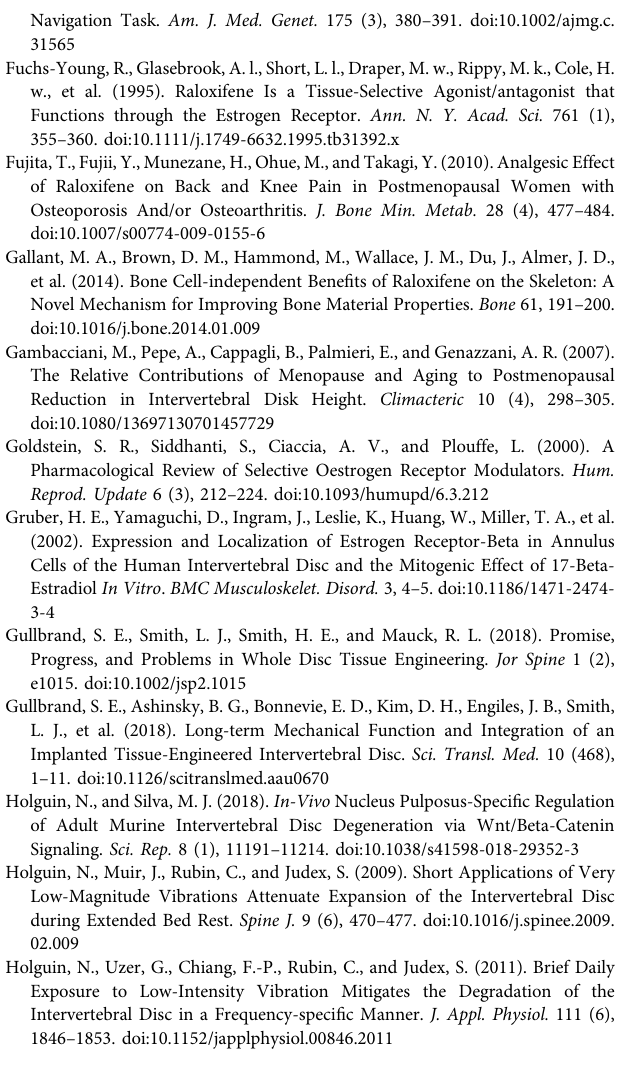
Supplementary Figure S10 | High magni fi cation of the NP of (Left: (A – C) ) SP- stained IVD and (Right: (A – C) ) the respective negative controls. The presence of protein stain is indicated by an arrow, whereas the absence of protein staining is indicated by an arrowhead. Scale: 50 μ m. Supplementary Figure S11 | Substance P protein cell count in the AF was increased by OVX and suppressed by raloxifene. Cell count of substance protein expressingcellsinthe(A)AFand(B)NPof young-adult(4 months),OVX(6 months), and old (24 months) mice. Data are represented as box plots with mean marked as cross (x), 25/75% deviation lines, and maximum/minimum whiskers. *: Control (CON, n = 5/sex/group) vs. raloxifene (RAL); R: CON vs RAL; S: male vs. female; RxS: interaction; vehicle (VEH, n = 8/group) vs RAL, SHAM ( n = 4 – 5/group) vs ovariectomized(OVX),p < 0.05.AF,annulus fi brosus;NP:nucleuspulposus;andND, not determined. Supplementary Figure S12 | ER- α staining in 4-month osteocytes. The presence of protein stain is indicated by an arrow, whereas the absence of protein staining is indicated by an arrowhead. Scale bar: 50 μ m. Supplementary Figure S13 | Substance P staining in osteocytes at a (A) high magni fi cation and the (B) negativecontrol. Thepresence ofprotein stainisindicated by an arrow, whereas the absence of protein staining is indicated by an arrowhead. Scale bar: 50 μ